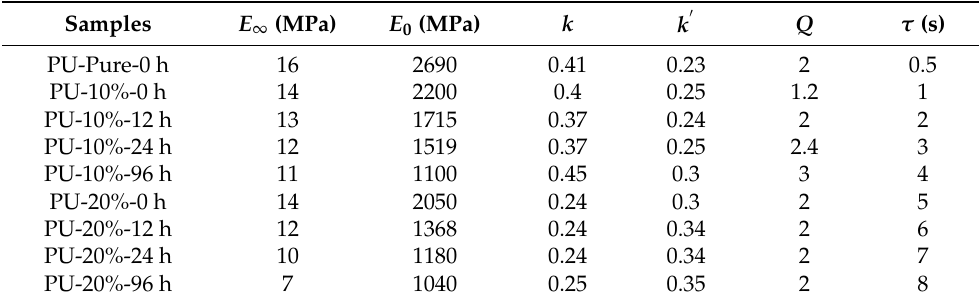
Table 1. Perez model parameters for PU and PU-10% and PU-20% of diclofenac at different release times at the flow rate of 7.5 mL/s (f = 1